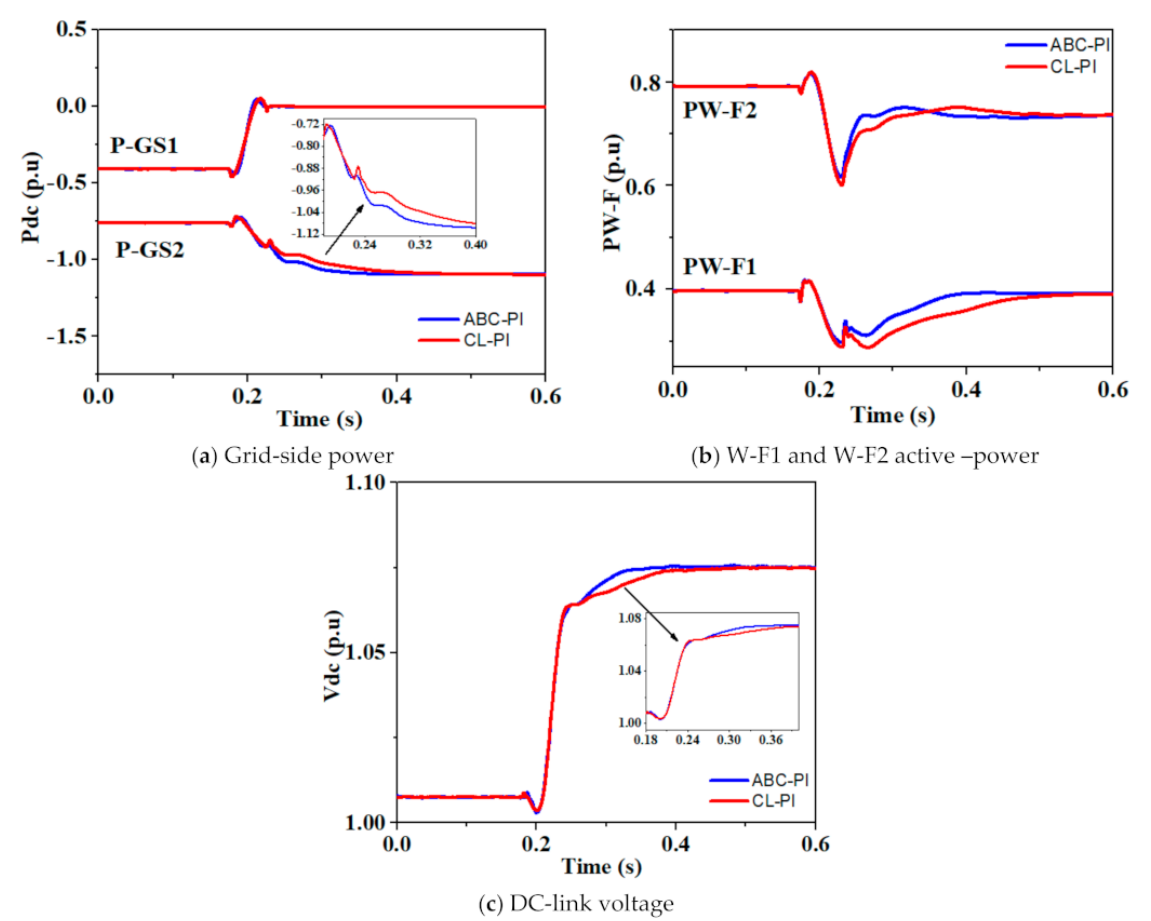
Figure 16. ( a ) Grid-side power, ( b ) W-F1 and W-F2 active-power, ( c ) DC-link voltage during dis-connection of